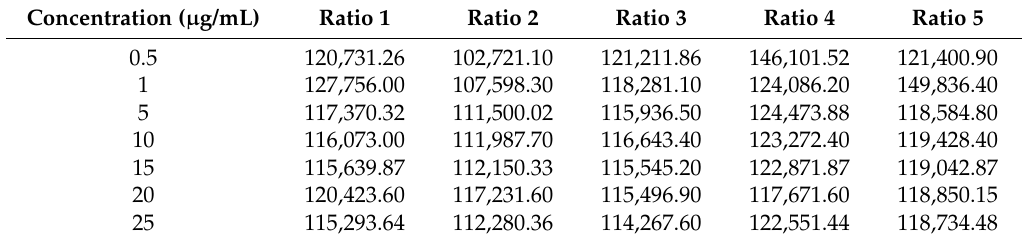
Table 3. HB standard curve and respective area response factor.